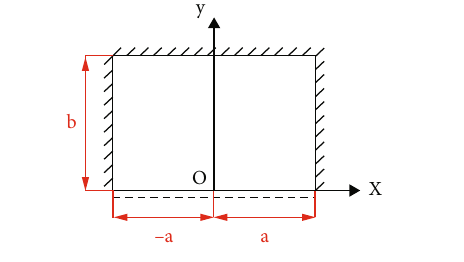
Figure 2: Mechanical model of small mining